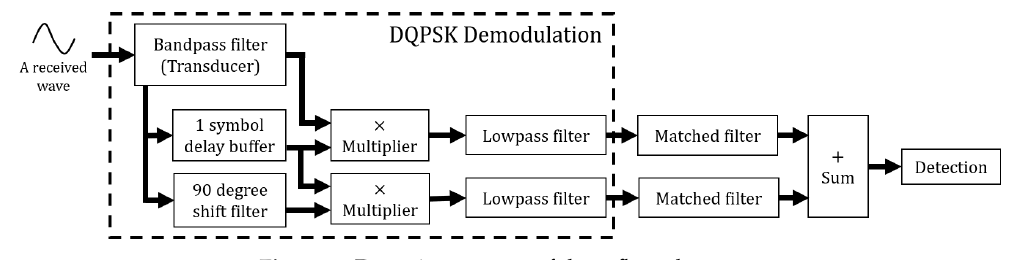
Figure 2. Detection process of the reflected